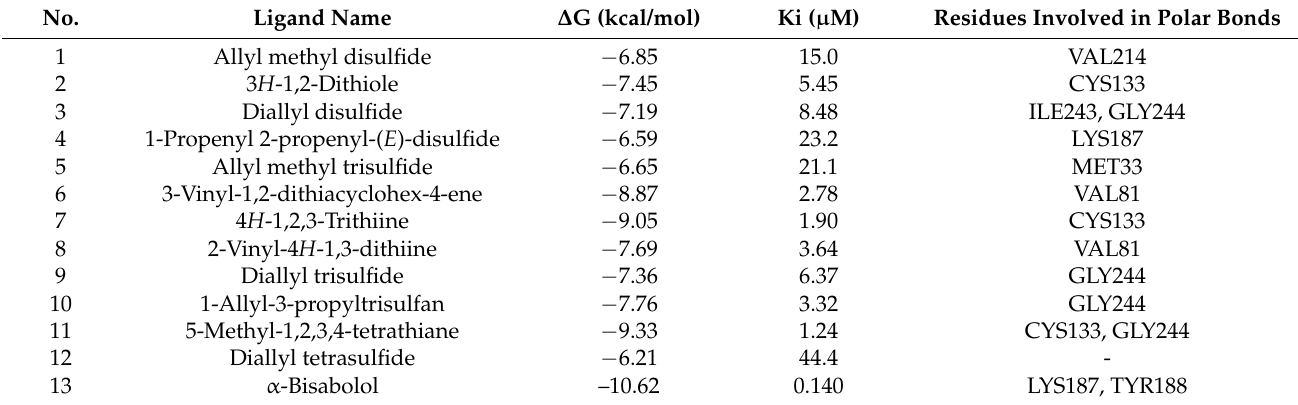
Table 3. Ligand interaction energies and inhibitory concentrations with NADPH oxidase in the molecular docking study.